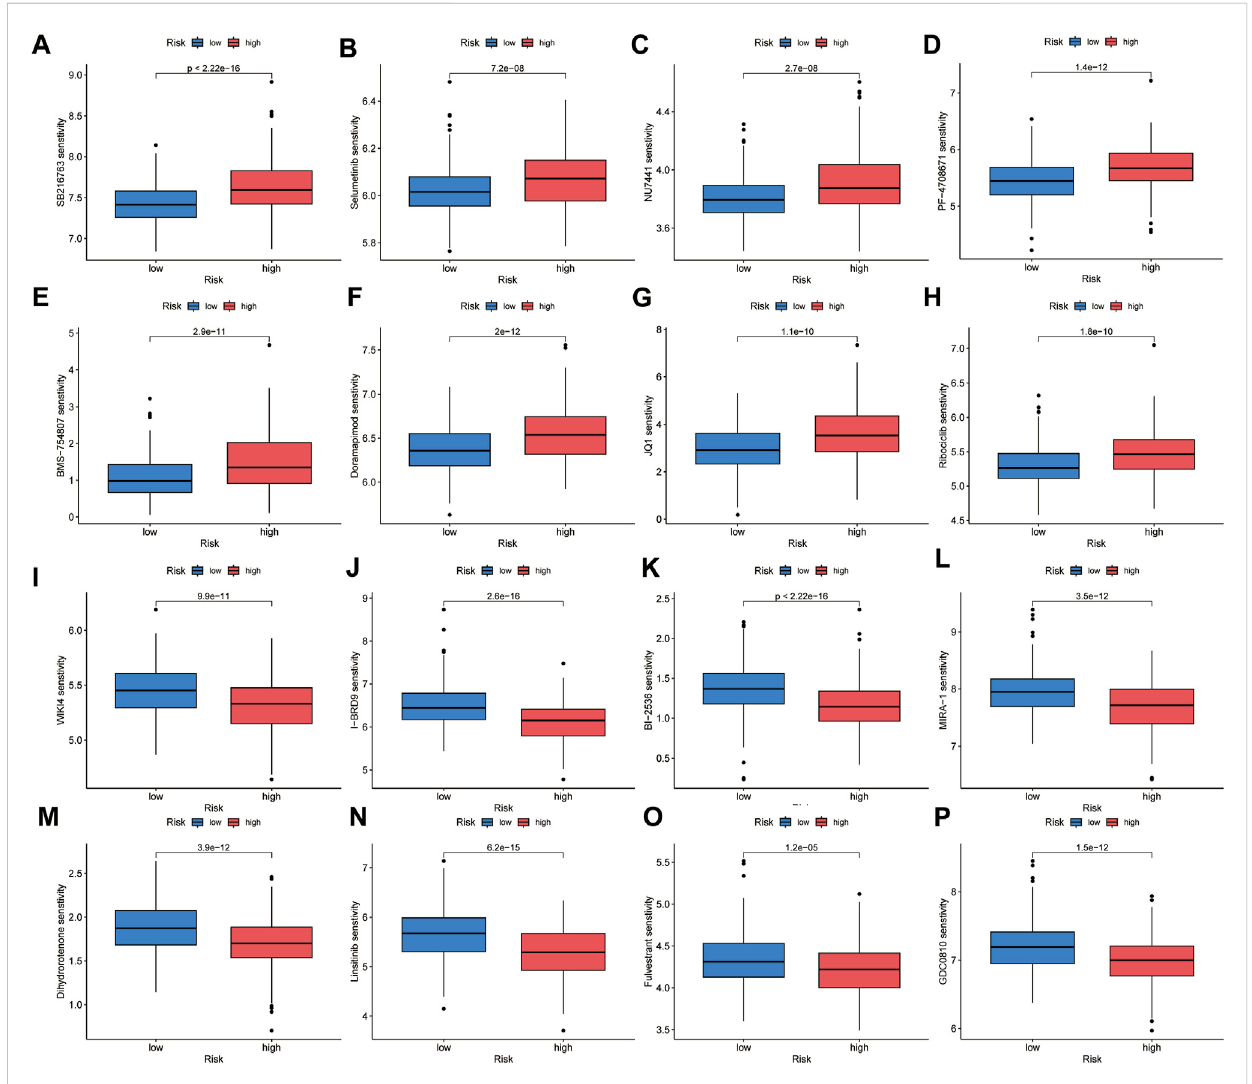
FIGURE 10 Chemotherapeutic sensitivity prediction. High-risk group showed lower sensitivity to SB216763 (A) , Selumetinib (B) , NU7441 (C) , PF-4708671 (D) , BMS-754807 (E) , Doramapimod (F) , JQ1 (G) and Ribociclib (H) , and higher sensitivity to WIKI4 (I) , I-BRD9 (J) , BI-2536 (K) , MIRA-1 (L) , Dihydrorotenone (M) , Linsitinib (N) , Fulvestrant (O) and GDC0810 (P)